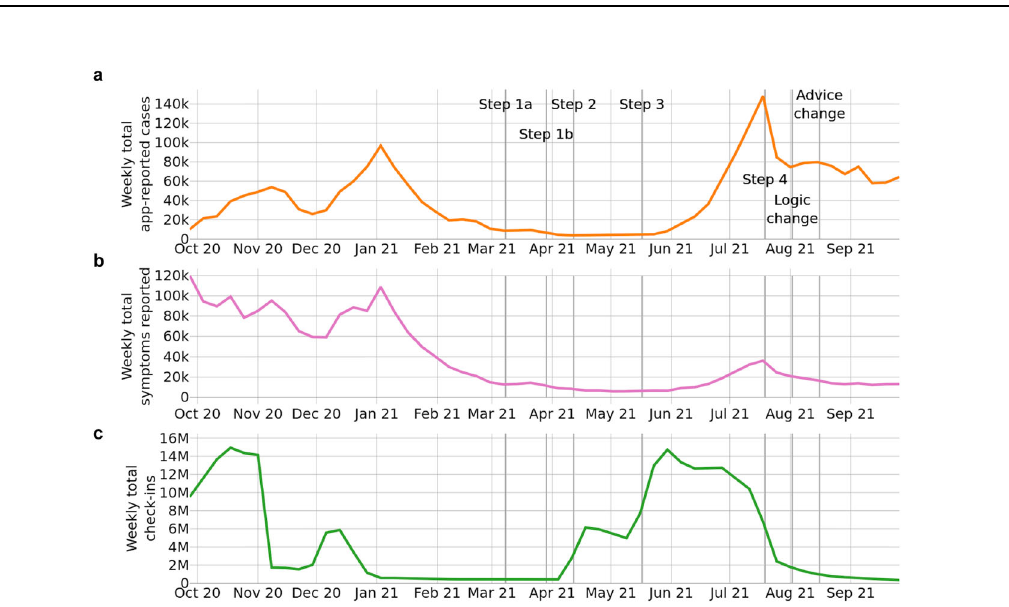
cases, and a policy change where some (mainly vaccinated) users were advised to take a PCR test rather than self-isolate upon noti fi cation. These events are descri- bed in more detail in a timeline in the Supplementary